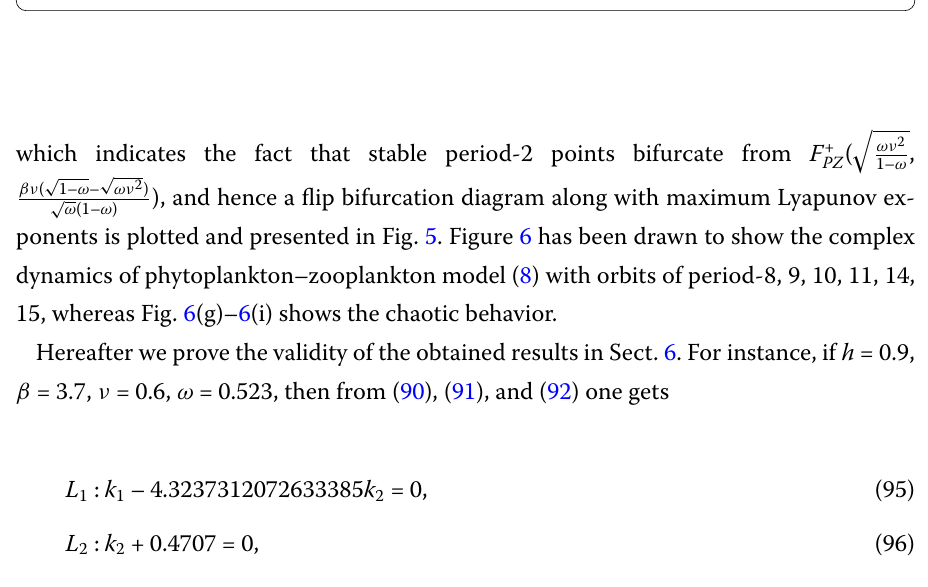
Figure 6 Complex and chaotic behavior of phytoplankton–zooplankton model (8)